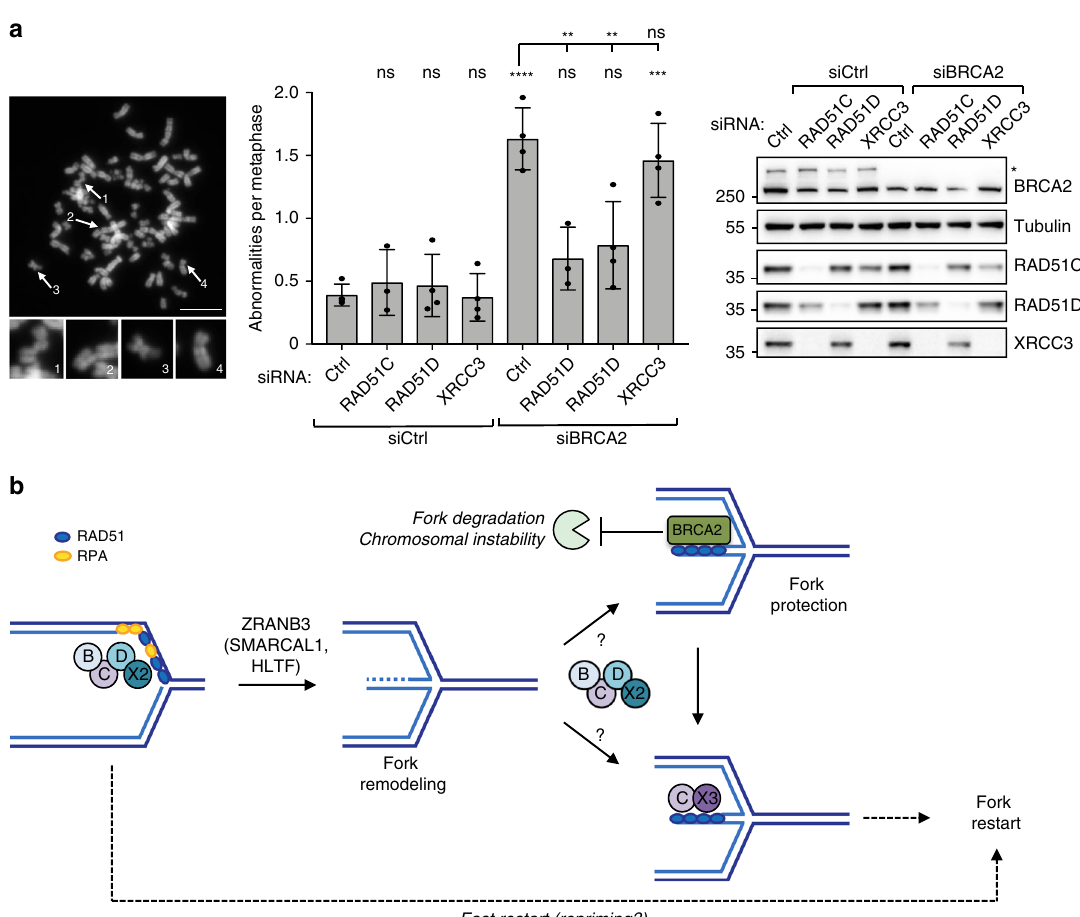
Fig. 5 BCDX2, but not CX3, promotes chromosomal instability in BRCA2-defective cells. a Metaphase spread analysis for detecting chromosomal aberrations in U2OS cells double transfected with a control siRNA (Ctrl) or with siRNAs targeting RAD51C , RAD51D , and XRCC3 for 60h and with BRCA2 siRNA for 48h and treated with 4 mM HU for 5hr. Left: representative metaphase spread image (scale-bar, 5 μ m); 1, 2, 3 representative breaks and 4 representative intact chromosome. Center: number of chromosomal abnormalities for each genetic condition. The graph-bar depicts mean and SD from at least three independent experiments. Statistical analysis: one-way ANOVA followed by Bonferroni test; ns not signi fi cant; ** p- value = 0.0012 (5 versus 6) and 0.0020 (5 versus 7); *** p -value = 0.0001; **** p- value < 0.0001. Right: levels of indicated proteins, assessed by western blot; Tubulin, loading control; asterisk, speci fi c band. Multiple gels/blots were processed in parallel, ensuring equal and comparable loading across gels. Source data are provided in the Source Data fi le. b Proposed model for the sequential role of BCDX2 and CX3 paralog complexes in replication fork remodeling, protection and restart: the BCDX2 complex helps RAD51 and ZRANB3 in driving fork remodeling. During fork stalling, regressed arms are protected from unscheduled nucleolytic degradation by BRCA2-mediated stabilization of RAD51 nucleo fi lament. Preventing fork remodeling by BCDX2 inactivation suppresses genetic instability of BRCA2-de fi cient cells upon sustained replicative stress. Similarly to RAD51, BCDX2 may be involved in fork protection (and possibly fork restart), but this role may be genetically masked by its upstream role in promoting fork reversal. Once DNA synthesis can resume, the CX3 complex promotes reversed fork restart, likely by engaging RAD51-bound regressed arms in ef fi cient strand invasion events. In absence of fork remodeling, stalled forks undergo a fast, but possibly inaccurate restart mode, likely driven by repriming